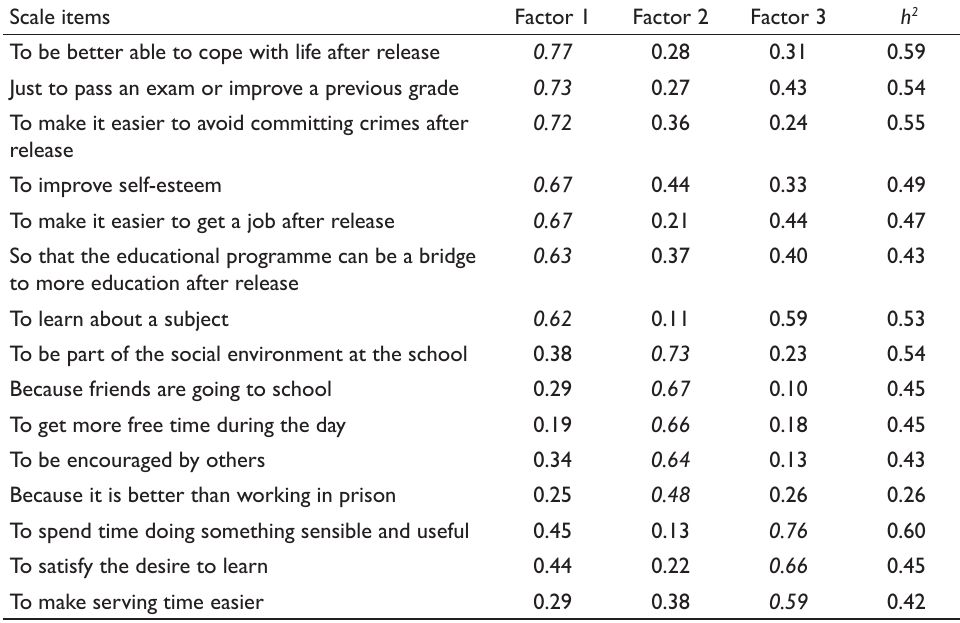
Table 1: Possible reasons for starting an education in prison